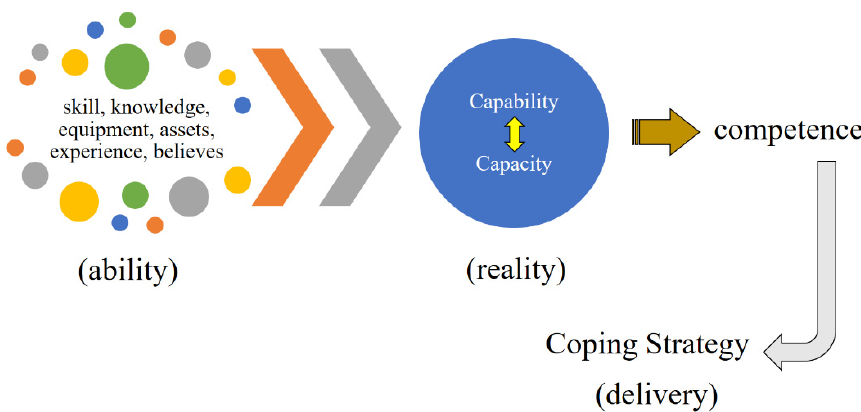
Figure 2. A successful community will be aware of all of its abilities, have realistic capacities, and be skilled in its